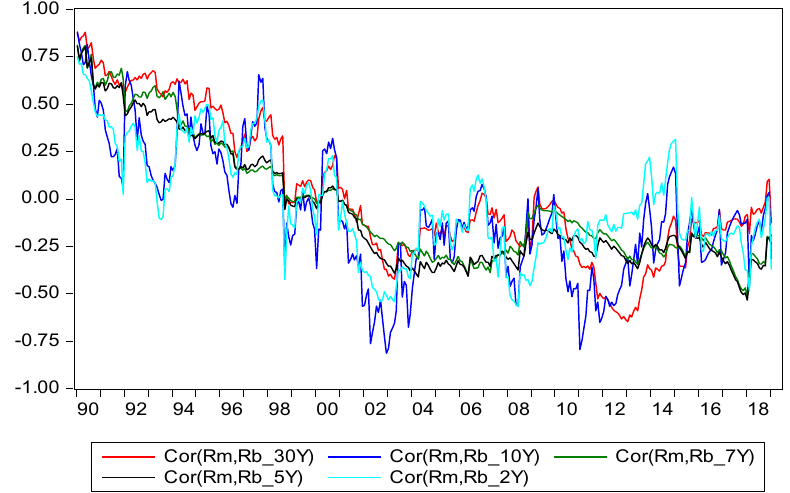
Figure 2. Dynamic correlations between stock (TTMK) and various bond returns in the US.